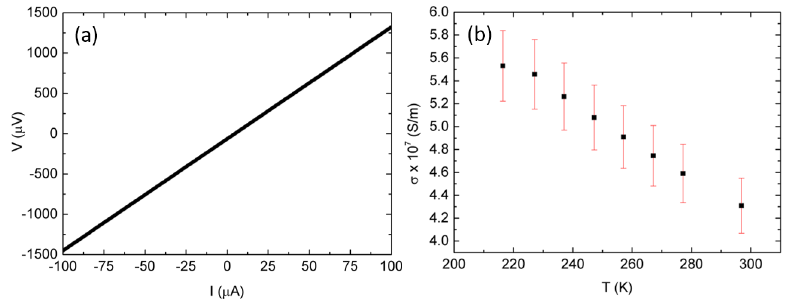
Figure 9. Ag nanowire electrical characterization using TNCP b . ( a ) I-V curve of the Ag nanowire at T = 297 K. The linear trend shows an ohmic contact. ( b ) Ag nanowire electrical conductivity. The conductivity decrease versus the temperature increase is a typical behavior of metals.